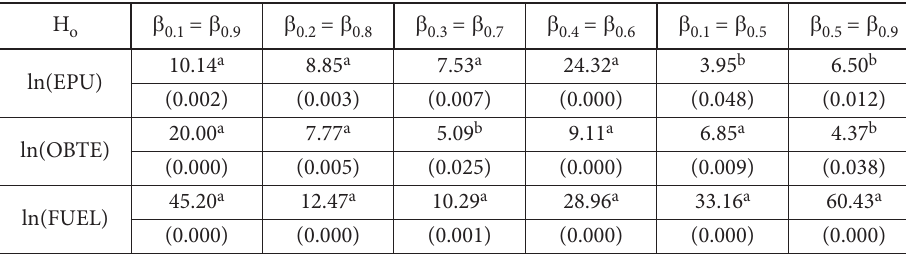
Table 5. Model 3: Results of the symmetric quantile